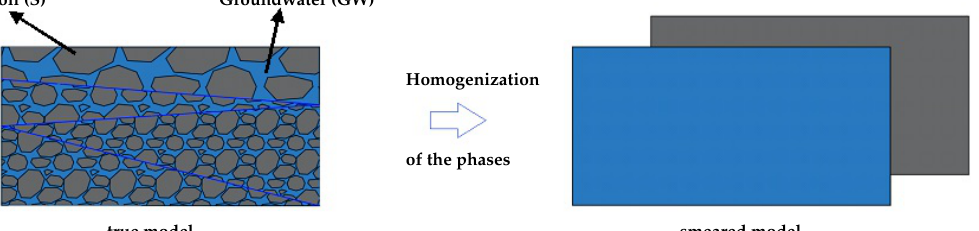
Figure 1. Representative volume element (RVE) of groundwater and soil and its